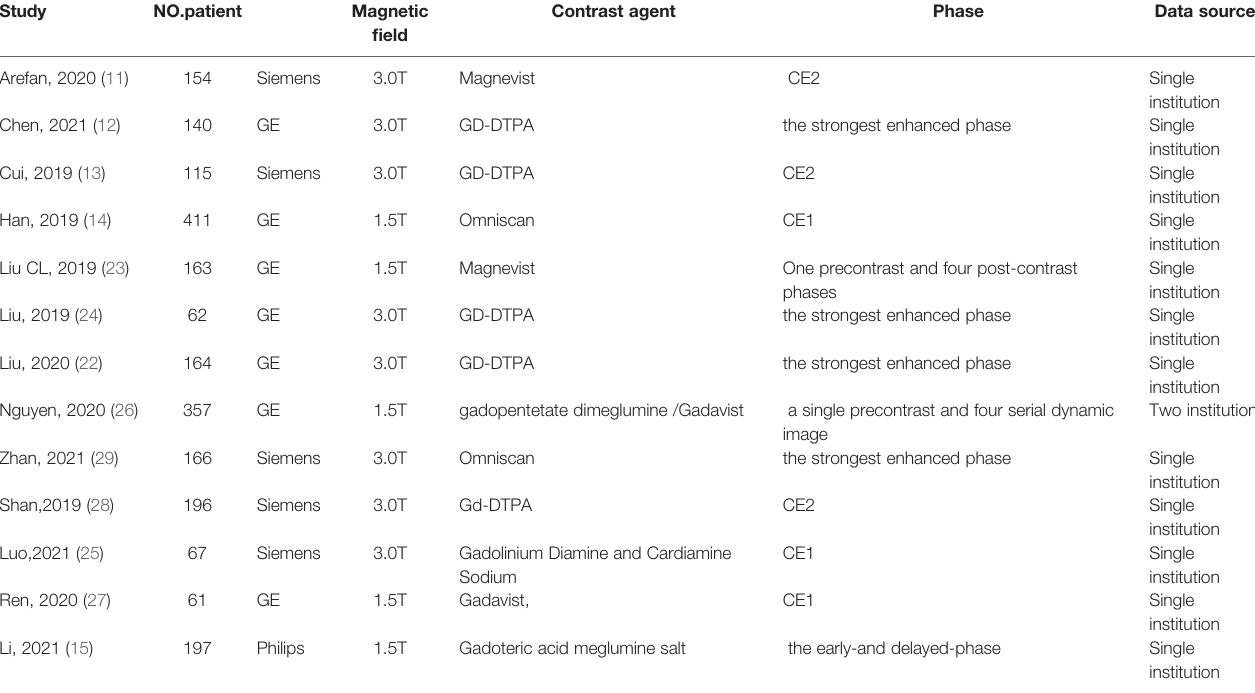
TABLE 2 | Baseline characteristic of included studies (1).